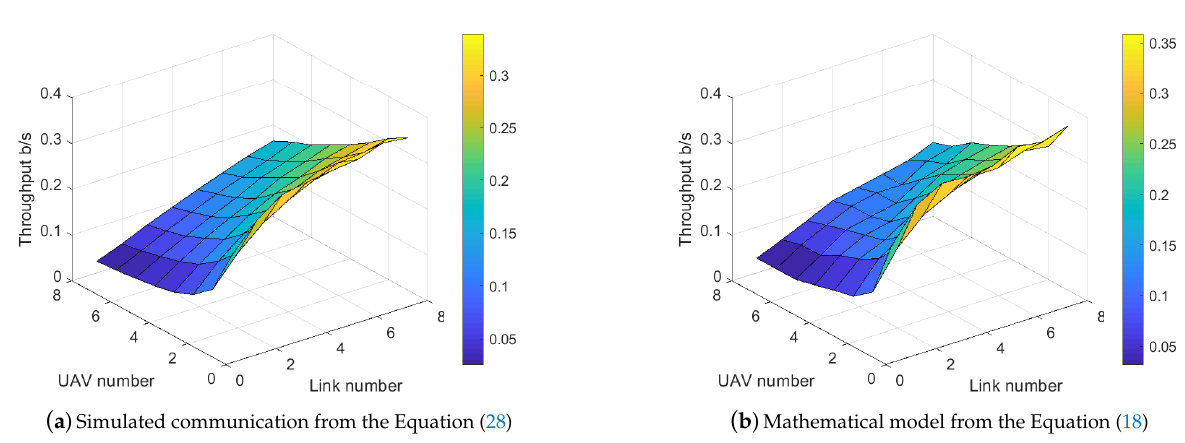
Figure 10. Saturation throughput per UAV derived from the simulated data and the mathematical model.